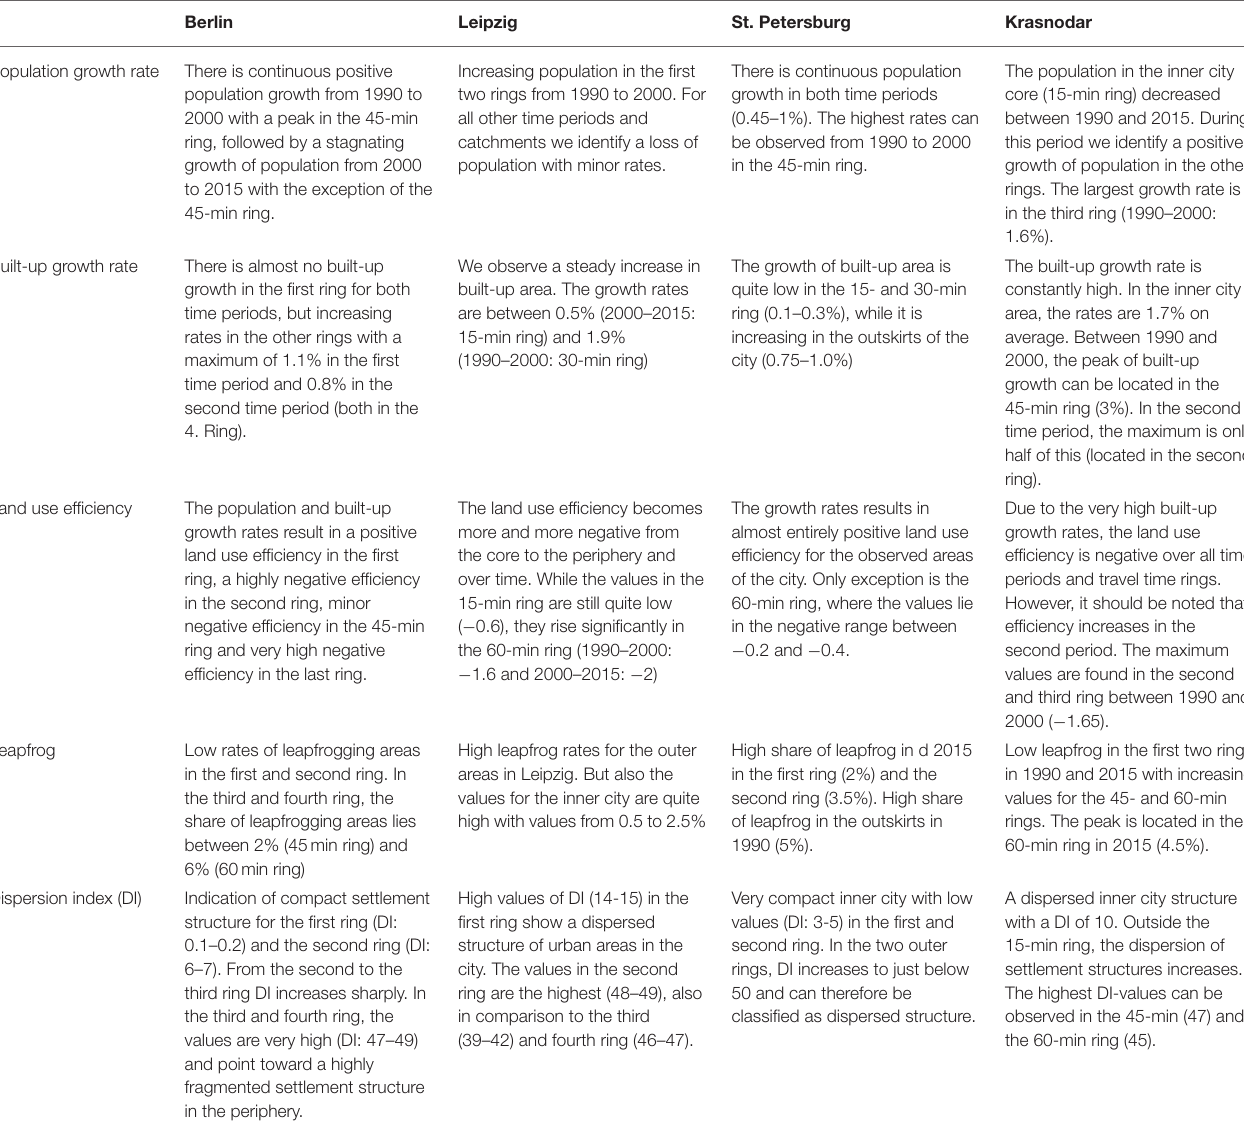
TABLE 1 | Summarized interpretations for the urban metrics by